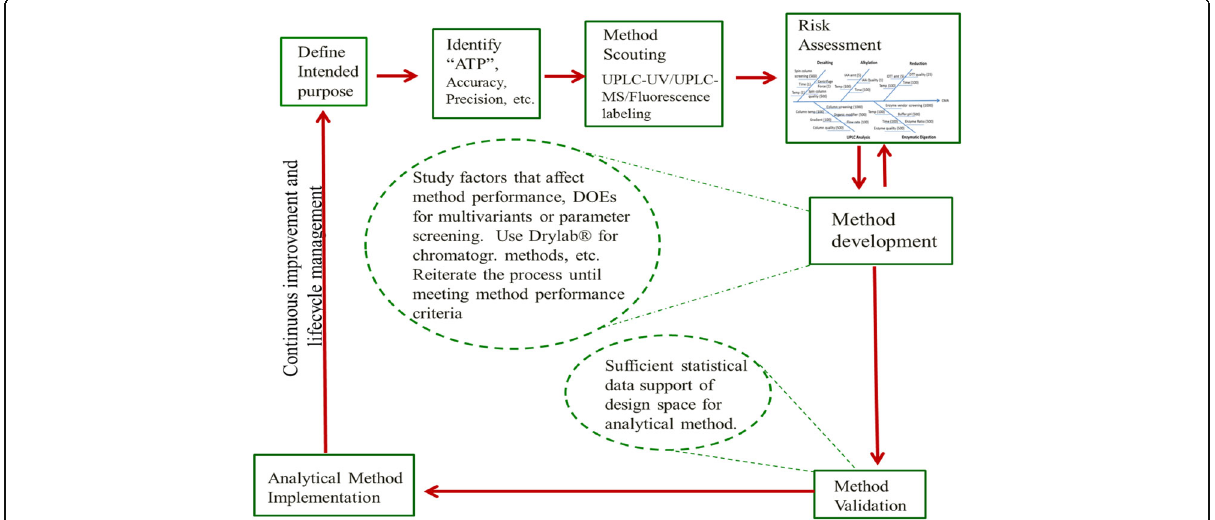
Fig. 4 A flow diagram illustrating the process of analytical quality by design (AQbD) (permitted to